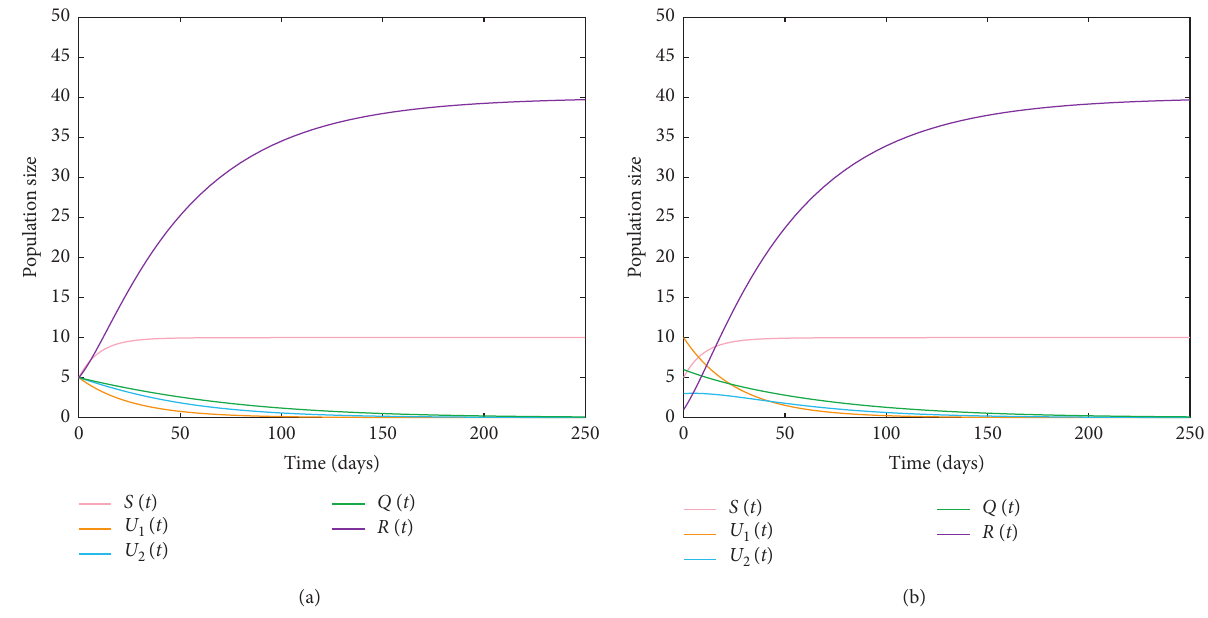
Figure 3: The stability of E an initial value I 2